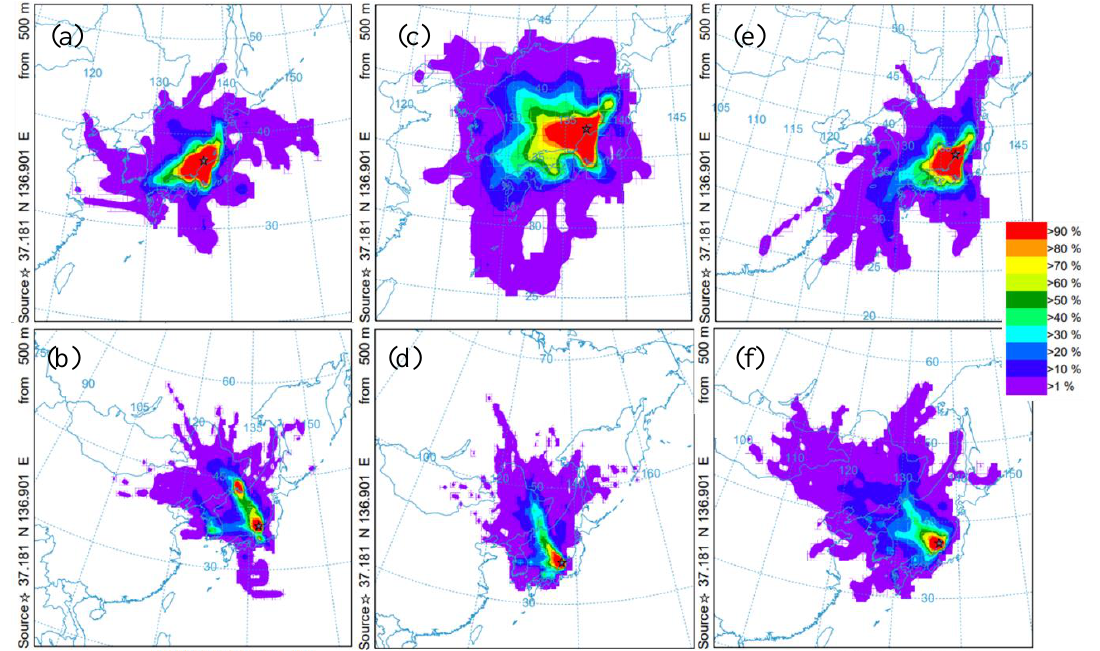
Figure 6. Distribution of trajectory frequencies during 32-day backward air mass (48 h) trajectories over the monitoring station. The upper panels display the summer seasons, whereas lower panels display the winter seasons. ( a ) summer, ~15 July, 2015, ( b ) winter, ~15 February, 2016, ( c ) summer, ~15 July, 2016, ( d ) winter, ~15 February, 2017, ( e ) summer, ~15 July, 2017, ( f ) winter, ~15 February, 2018.